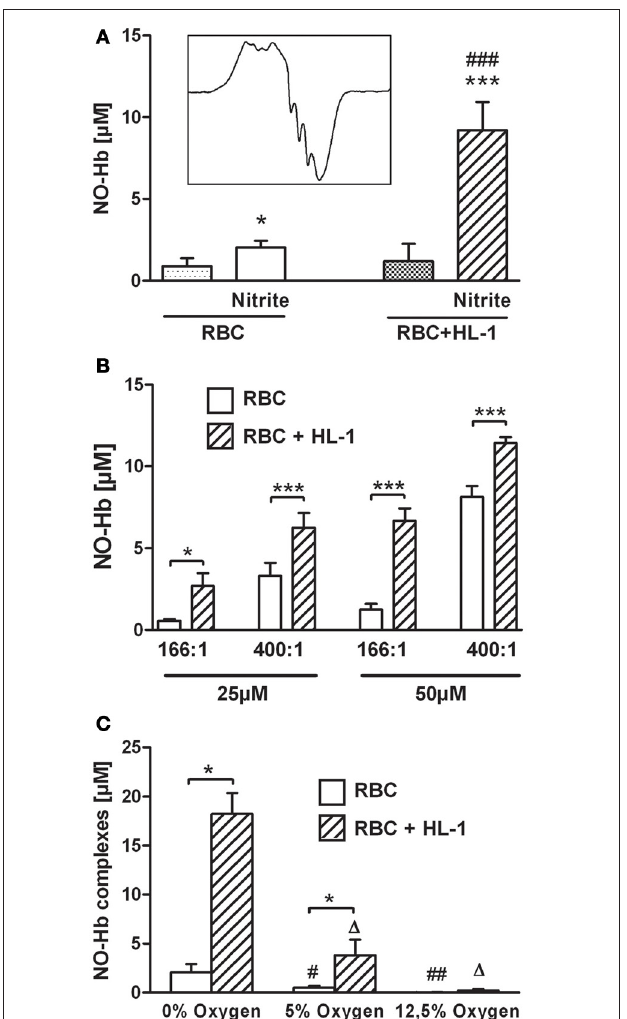
FIGURE 1 | (A) NO production from RBC and in co-culture with HL-1 cells under hypoxic conditions with and without 50 µ M nitrite. (A) Both RBC and HL-1 cells are capable of nitrite reduction. Left set of bars shows the RBC-mediated release of NO from nitrite. Right set of bars represents data from co-culture of RBC with HL-cells in a RBC:HL-1 ratio of 166:1 ( ∗ p < 0 . 005, ∗∗∗ p < 0 . 001 compared to the respective group without nitrite, ### p < 0 . 001, compared to RBC with nitrite). Inset in 1 (A) shows typical EPR spectrum of NO-Hb complexes. (B) The relative contribution of both pathways depends on both nitrite concentrations and the RBC:HL-1 ratio. A ratio of 166:1 and a nitrite concentration of 50 µ M were chosen for all other experiments as these conditions showed the highest difference inNO-signals with and without HL-1 cells. ∗ p < 0 . 05, ∗∗∗ p < 0 . 001 RBC vs. RBC + HL-1 of the same group. (C) Oxygen-dependenceof NO-Hb signal. RBC and in co-culture with HL-1 cells were incubated with 50 µ M nitrite under various oxygen concentrations. ∗ p < 0 . 001, NO-Hb signals with and without HL-1 cells. (cid:2) p < 0 . 001, compared to RBC + HL-1 at 0% oxygen. # , ## p < 0 . 05 and p < 0 . 01, respectively, compared to RBC at 0%